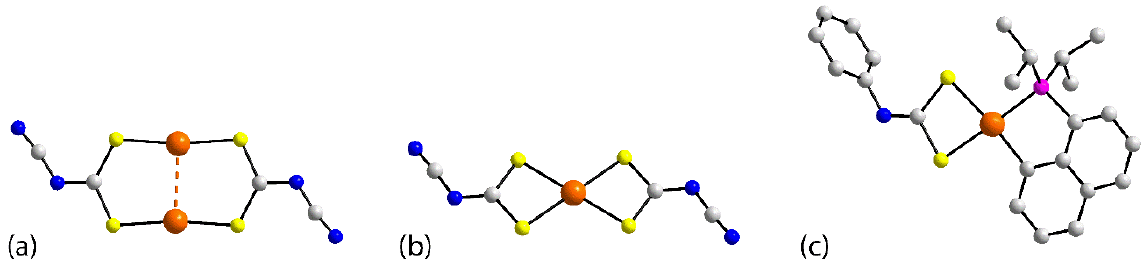
Figure 7. Molecular structures of ( a ) the {Au[S 2 C=N(CN)] 2 } 2 − di-anion in 28 , ( b ) the {Au[S 2 C=N(CN)] 2 } − anion in 29 , and ( c ) (iPr) 2 P(C 10 H 6 -P,C)Au[S 2 C=N(Ph)] in 32 . In (a), the orange dashed line indicates an aurophilic (Au … Au) interaction.